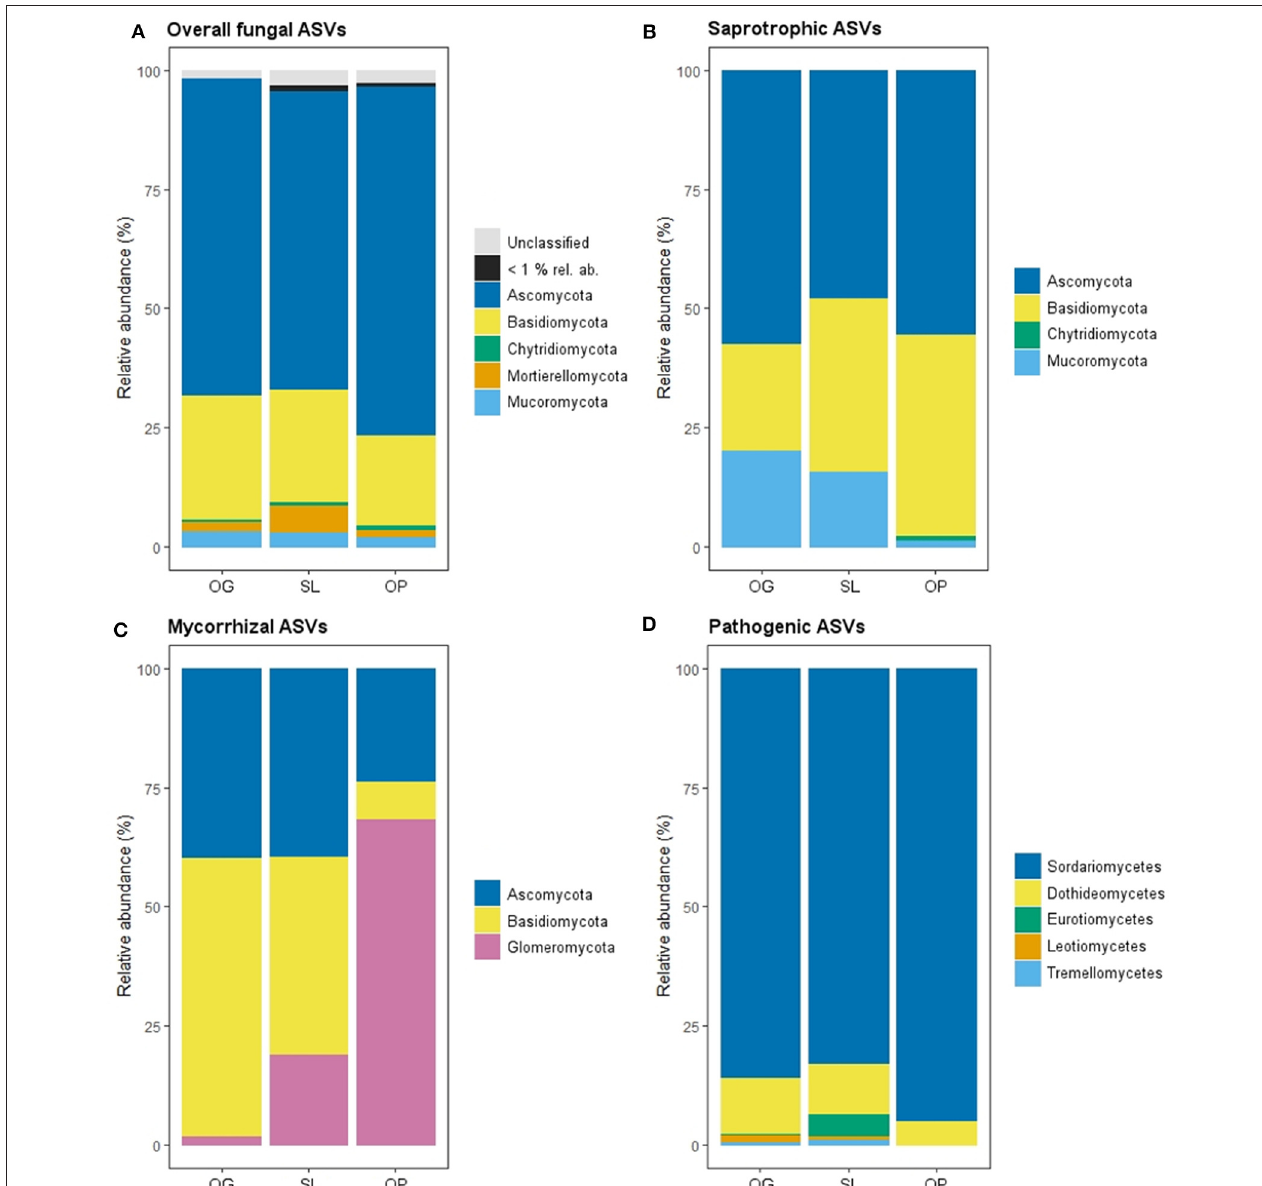
FIGURE 1 | Relative abundance of mycelial fungal phyla as a percentage of total Amplicon Sequence Variants (ASVs) in old-growth (OG) and selectively logged (SL) lowland dipterocarp rainforest and oil palm plantation (OP) in Sabah, Borneo, for (A) overall, (B) saprotrophic, (C) mycorrhizal fungal groups. Phyla with < 1% relative abundance across all forest land-use types are represented as one group for overall fungi. (D) Relative abundances of classes of mycelial pathogenic fungi. Phyla are not shown for this fungal group as reads were dominated by one phylum (Ascomycota: 98.76% in OG, 100% in SL and 99.38 in OP) with the remaining reads comprising taxa of the